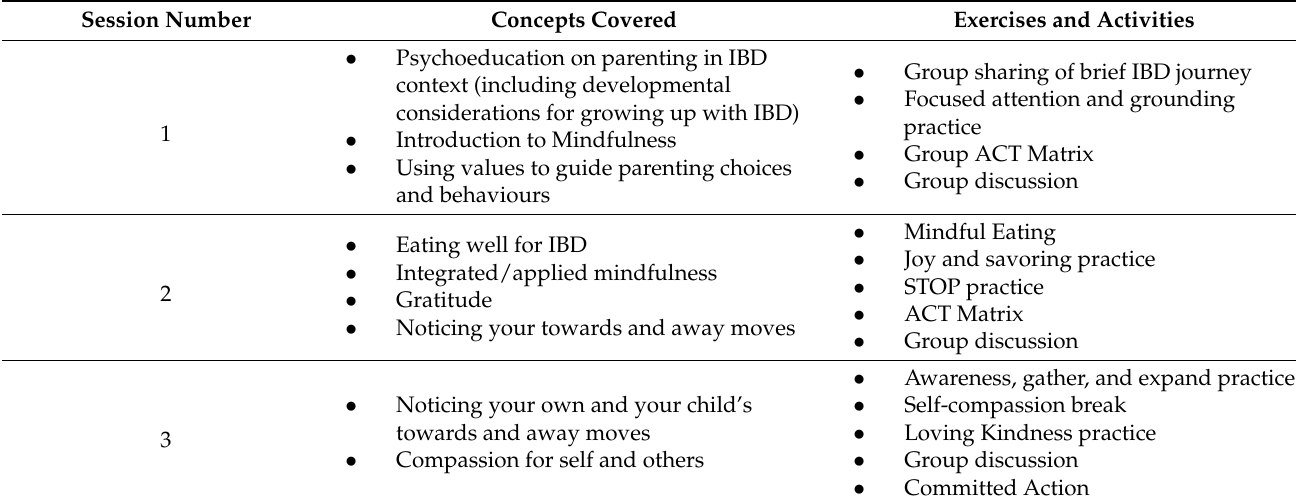
Table 1. iACT-P workshop session